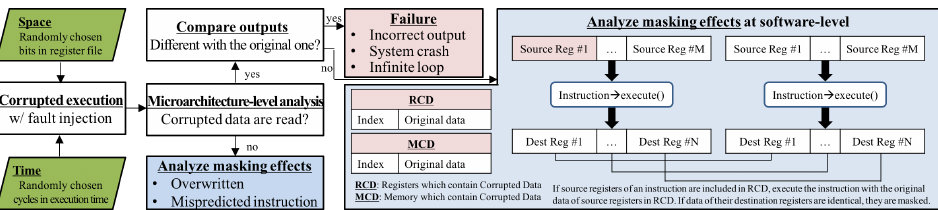
Figure 5. System-level masking effect analysis framework based on exhaustive fault injection